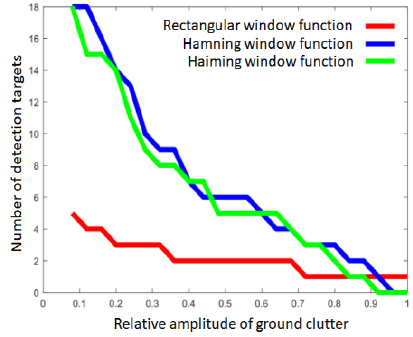
Figure 21. Effect of relative amplitude of surface clutter on test results during simulation.